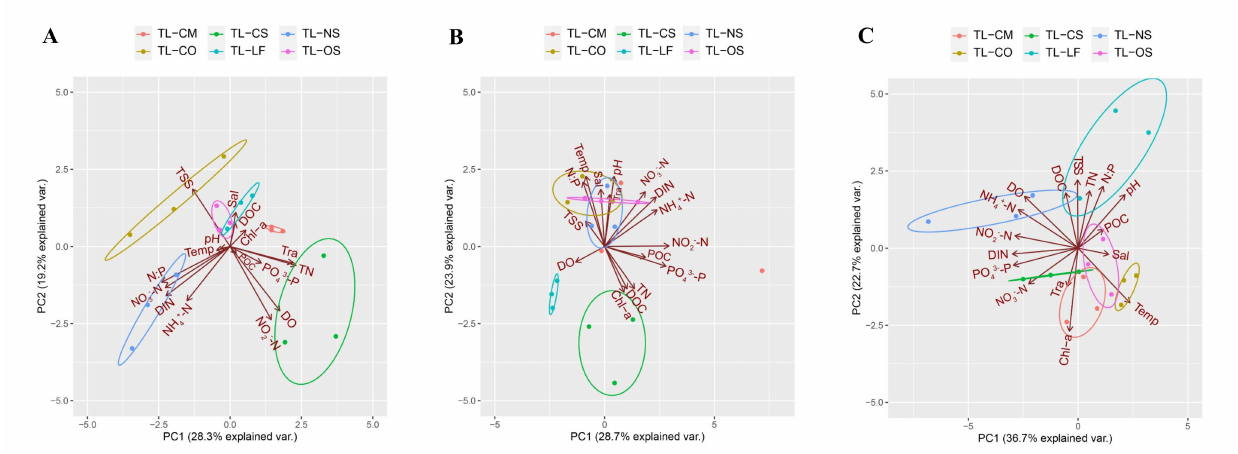
Figure 2. Biplot of the principal component analysis (PCA) for environmental parameters in various sampling stations in September ( A ), October ( B ) and December ( C ). Red arrows represent envi- ronmental variables, the directions of arrows represent correlation between variable and principle components, lengths represent devotion of environmental parameters data to principle components, and circles in color represents sampling points. Ellipses represent 68% confidence intervals of core re- gions. The abbreviations of the sites are the same in Figure 1. The abbreviations of the environmental parameters are the same in Table